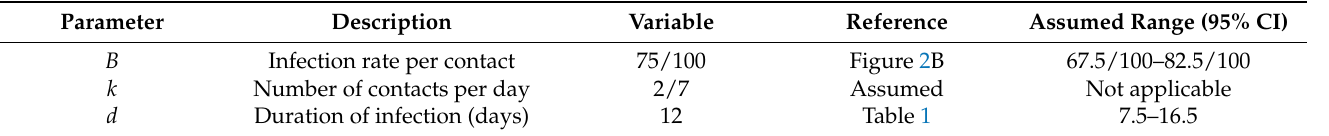
Table 2. Parameters used in HLD model of tomato bacterial canker